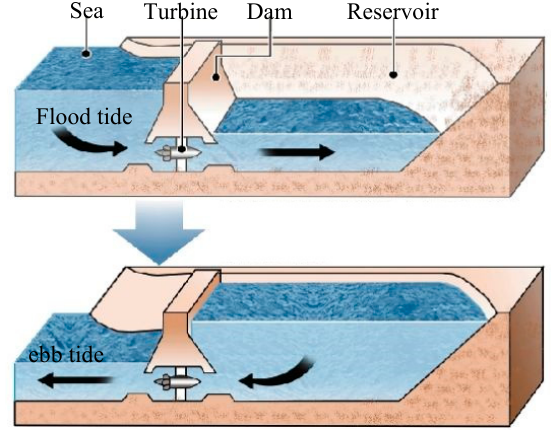
Figure 1. The operating principal of the bidirectional tidal turbine.